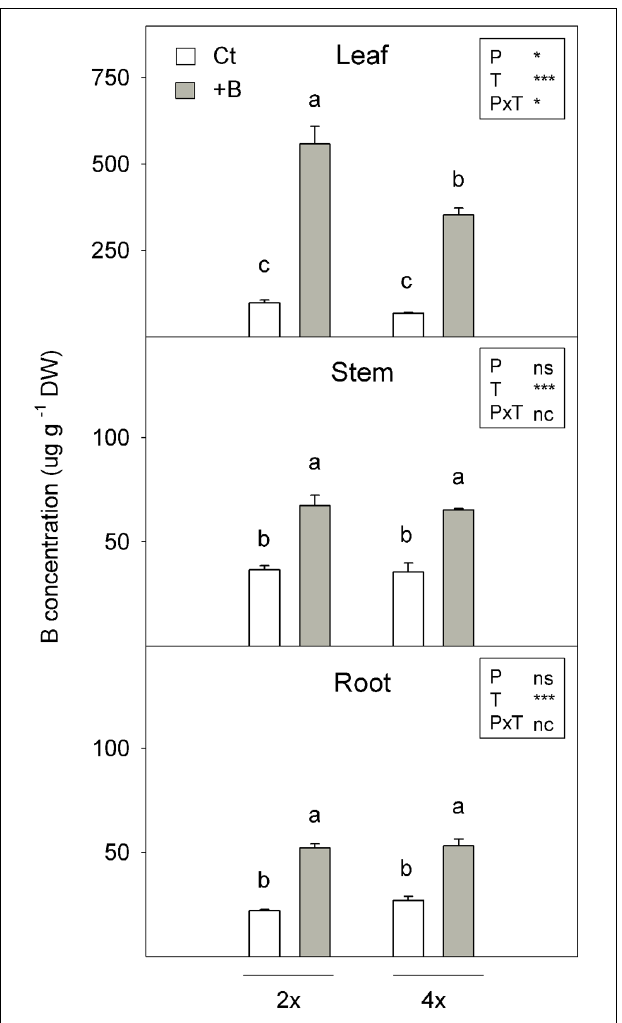
FIGURE 1 | Boron (B) concentration ( µ g g − 1 DW) measured in the 2x and 4x CC seedlings grown in vitro (Experiment 1) for 45 days in nutrient media supplemented with 50 µ M (Ct) or 400 µ M ( + B) H 3 BO 3 . Values are the means ± SE of six plants ( n = 6). Ploidy (P) and treatment